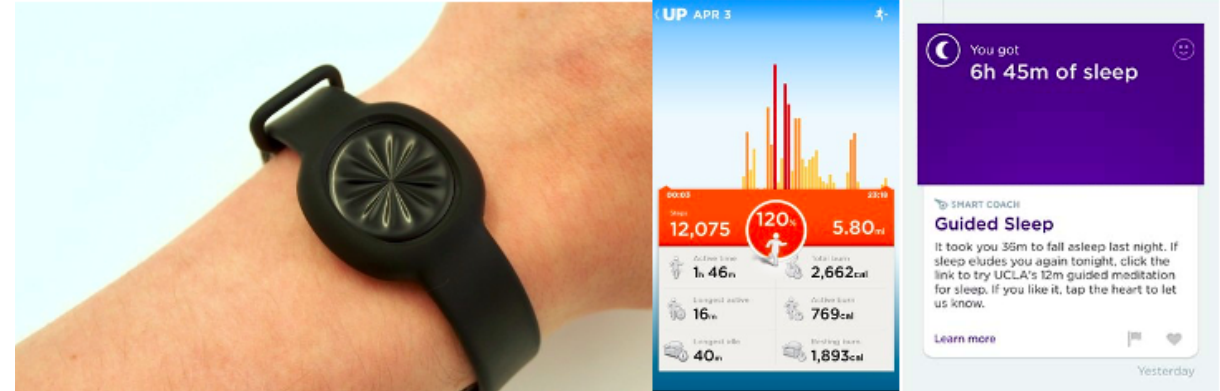
Figure 1. Jawbone UP Move accelerometer and mobile phone